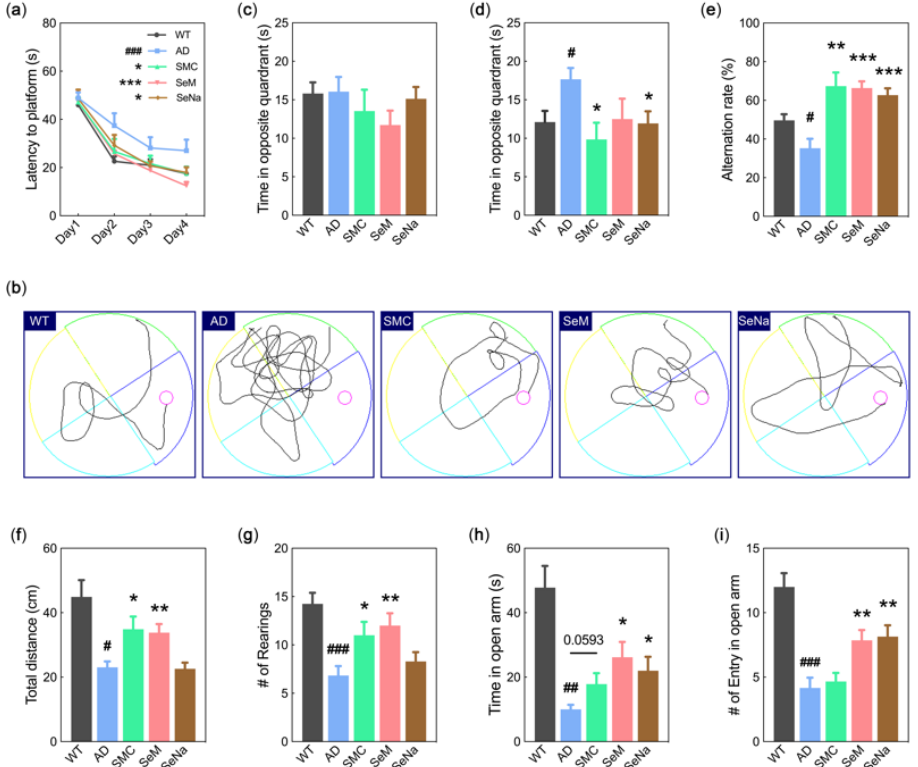
Figure 1. Behavioral tests in the WT, 3 × Tg-AD, SMC, SeM, and SeNa mouse groups. ( a – d ) The learning and memory abilities of mice were tested using the Morris water maze. ( a , b ) The escape latency ( a ) and swimming trajectory ( b ) were recorded during the 4-day training. ( c , d ) The probe trial was performed 24 and 72 h after the last trial of a hidden platform task. Time in the opposite quadrant after 24 h ( c ) and 72 h ( d ) was recorded. ( e ) The spatial memory of mice was determined by analysis of the alternation rate in the Y-maze. ( f , g ) Total distance ( f ) and number of rearings ( g ) in the open-field test were used to detect the autonomous behavior ability of mice. ( h , i ) Mouse anxiety was assessed by the elevated plus maze. Time in the open arm ( h ) and number of entries in the open arm ( i ) were recorded. All data are presented as the means ± SEMs ( n = 7–10). * p < 0.05, ** p < 0.01, *** p < 0.001 vs. AD mice; # p < 0.05, ## p < 0.01, ### p < 0.001 vs. WT mice, as determined by one-way or two-way ANOVA followed by Dunnett’s multiple comparison